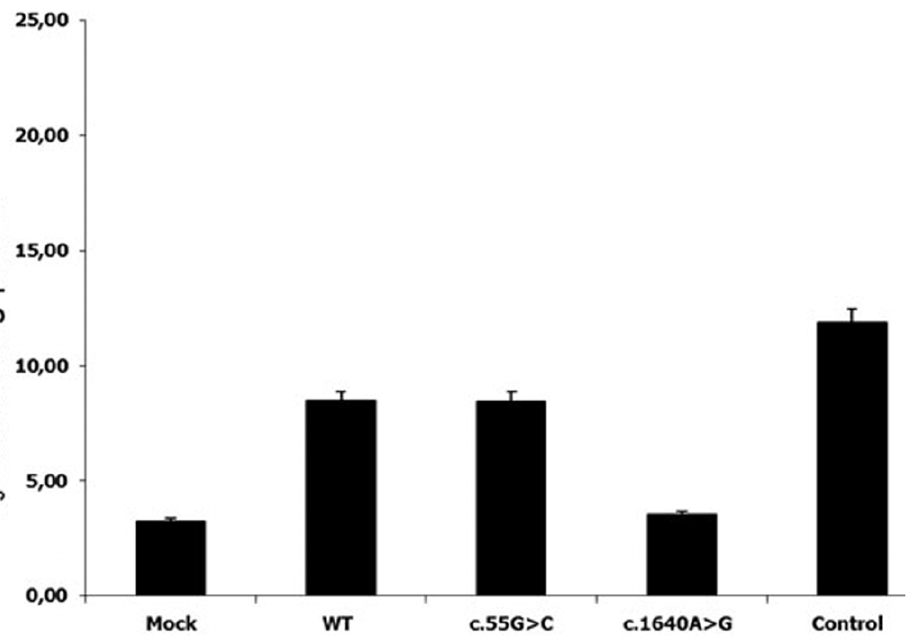
Figure 2. Peroxisomal b -oxidation was measured using stable-isotope labeled VLCFA (modified from Kemp et al., 2004). D3-C16:0 levels in normal (positive control), X-ALDfibroblast (mock) and X-ALD tranfected fibroblasts with a contruct with either wild type (WT) and each mutant ALDP.